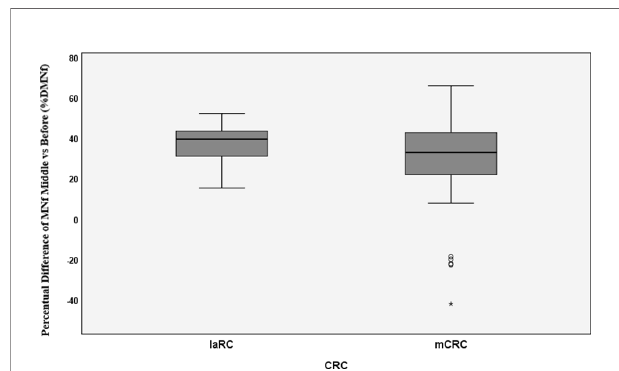
FIGURE 2 | Percentual difference between middle and before measurements of MNf for metastatic colorectal cancer (mCRC) and locally advanced rectal cancer (laRC). * = extreme value as marked in SPSS.